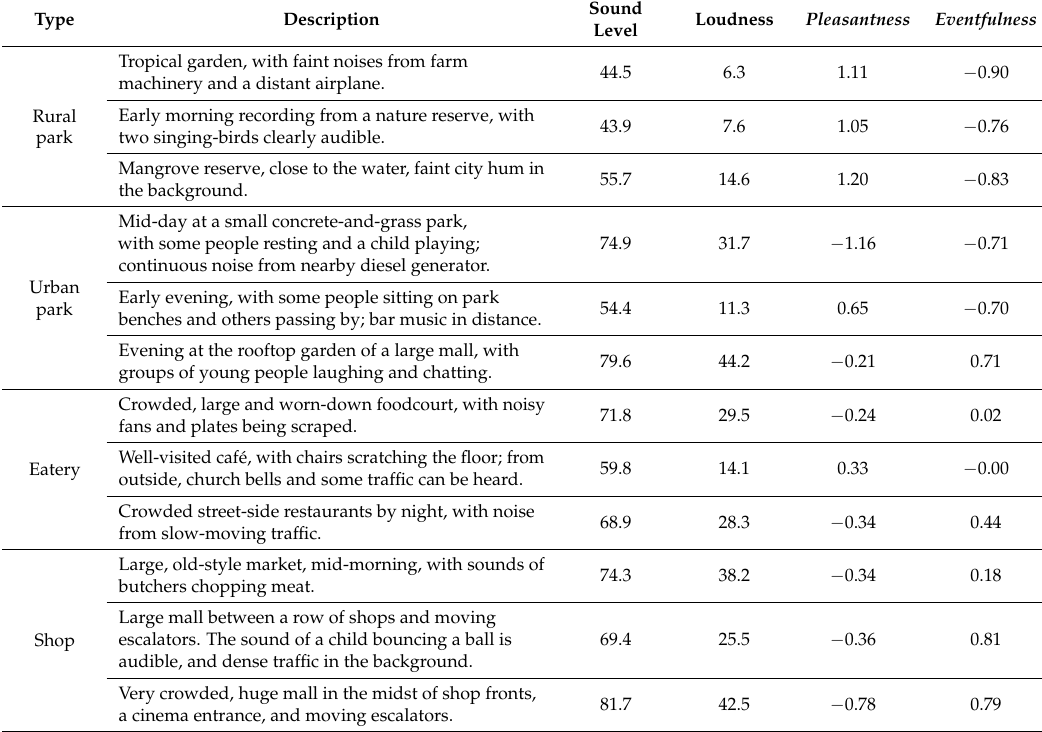
Table 1. Characteristics of urban soundscapes in Experiment 1. Sound level (LA eq,90s ) in dB re 20 µ Pa; Loudness ( N 10 ) in sone. Pleasantness and Eventfulness = mean scores from Swedish Soundscape Quality Protocol (SSQP)